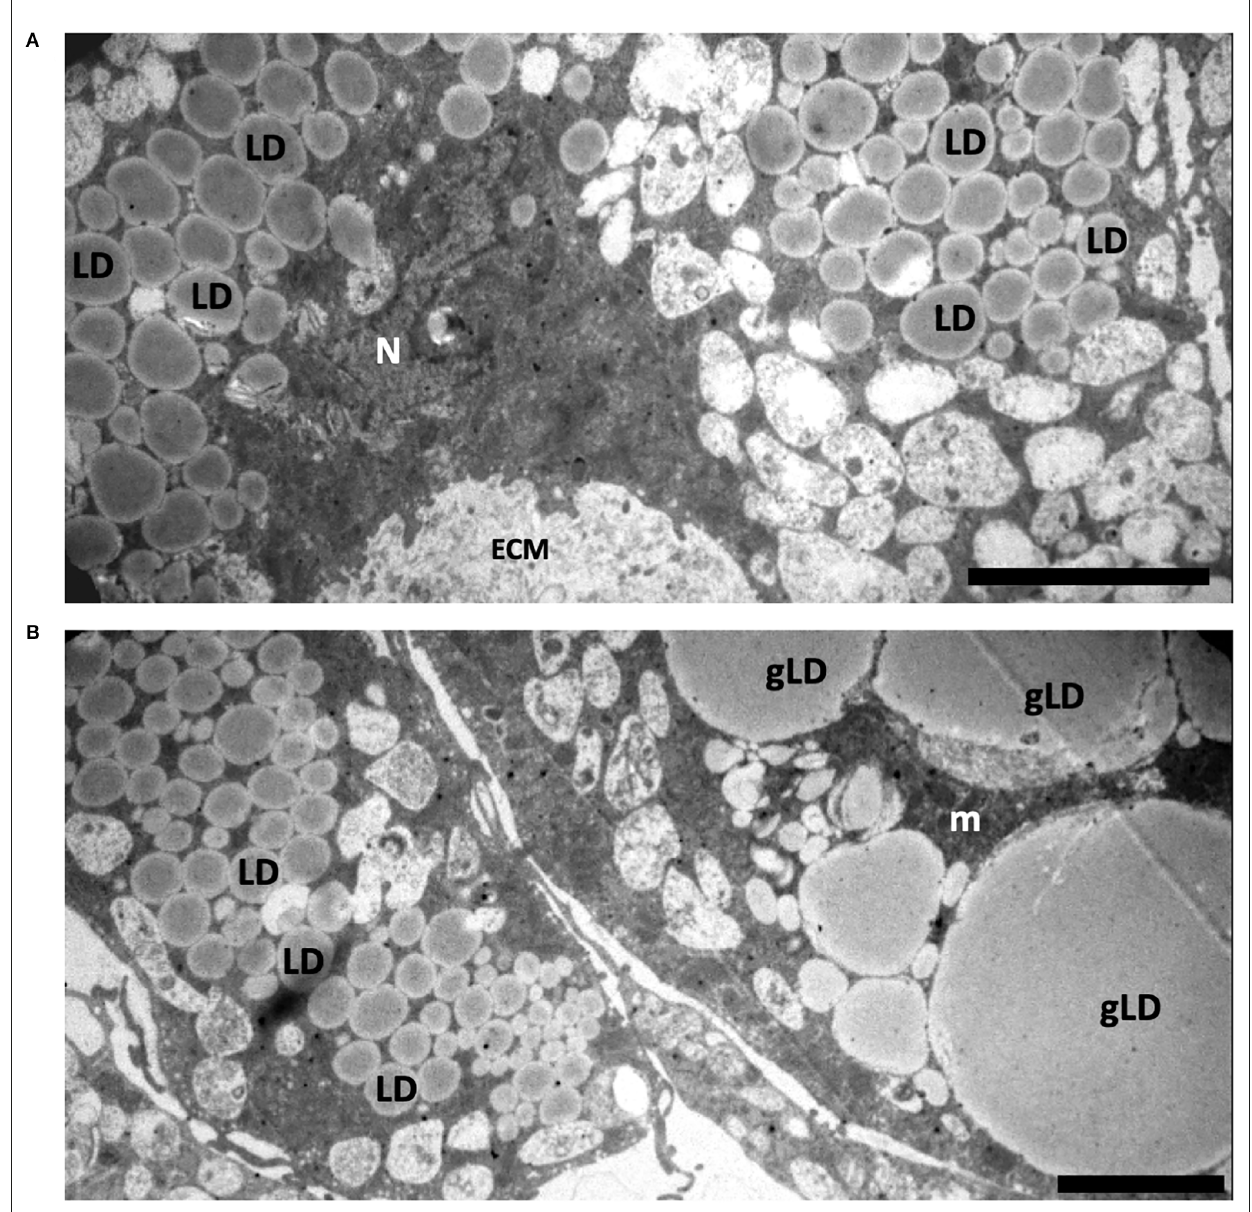
FIGURE5 Structure of spheroids of the adipose-derived multipotent mesenchymal stromal cells from young (A) and old (B) ovariectomized CBA/Ca mice. (A) The cytoplasm of ADSCs from young ovariectomized mice have a large number of lipid droplets (LD) and endosomal elements. ECM—extracellular matrix. N—nuclei. (B) The cell cytoplasm of ADSCs from old ovariectomized mice contains giant lipid droplets (gLD). m—mitochondria. Scale bars: (A,B) —2 µ